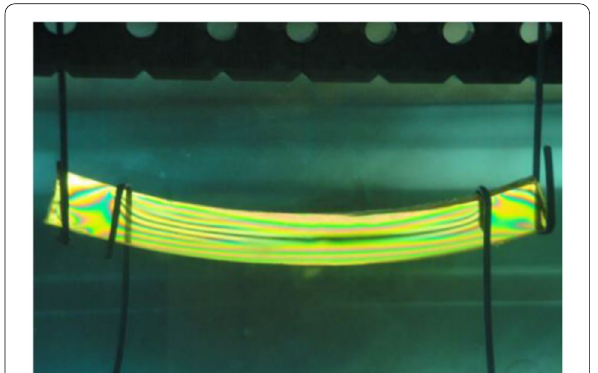
Figure 14 Four-point bending test using photo-elastic technique